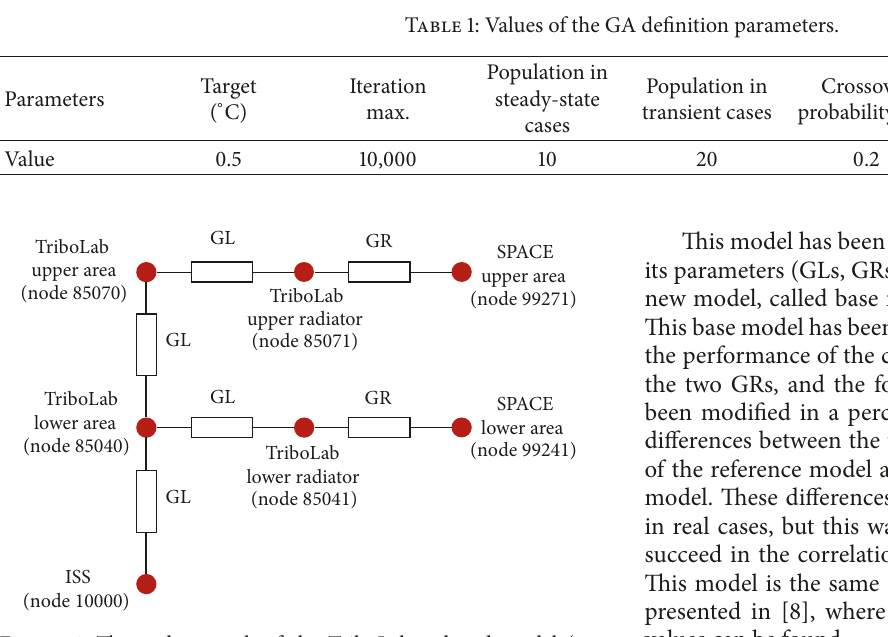
Figure 1: Thermal network of the TriboLab reduced model (re- printed from Acta Astronautica, 108 (2015), Eva Anglada and I˜naki Garmendia, Correlation of thermal mathematical models for thermal control of space vehicles by means of genetic algorithms, 1–17, Copyright (2014), with permission from